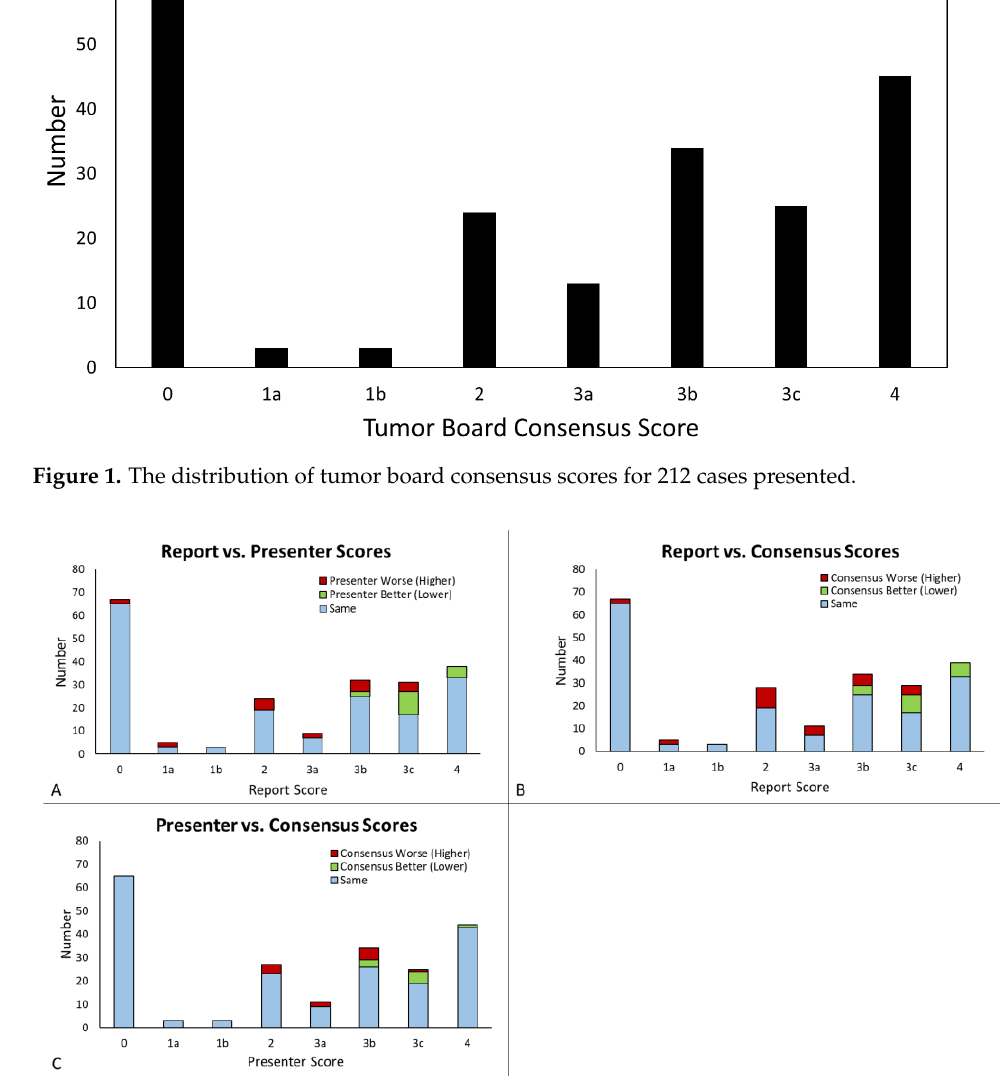
Figure 2. Frequency of agreement between report, presenter, and consensus MRI scores. ( A ) The report scores compared with the presenter scores, with higher presenter scores shown in red and lower presenter scores shown in green. ( B ) The report scores compared with the consensus score, with higher consensus scores shown in red and lower consensus scores shown in green. ( C ) Presenter scores compared with the consensus score, with higher consensus scores shown in red and lower consensus scores shown in green.